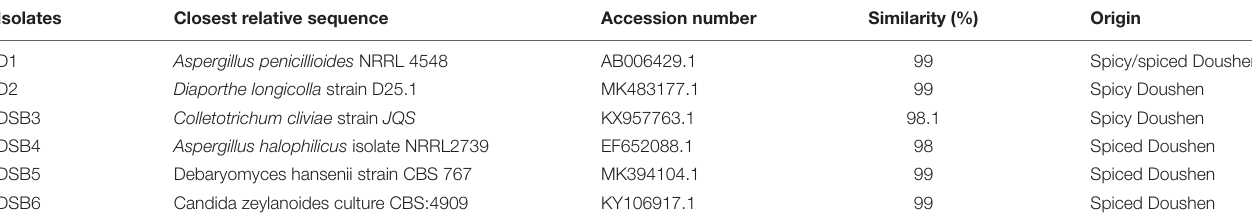
TABLE 5 | The closest related type strains of sequences of isolates from Doushen in NCBI Genbank. Isolates Closest relative